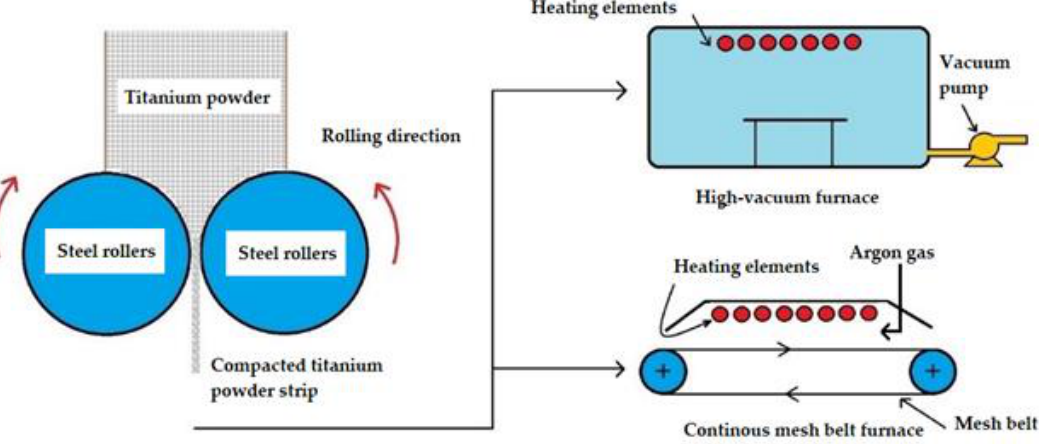
Figure 2. The direct powder rolling process and sintering furnaces (adapted from